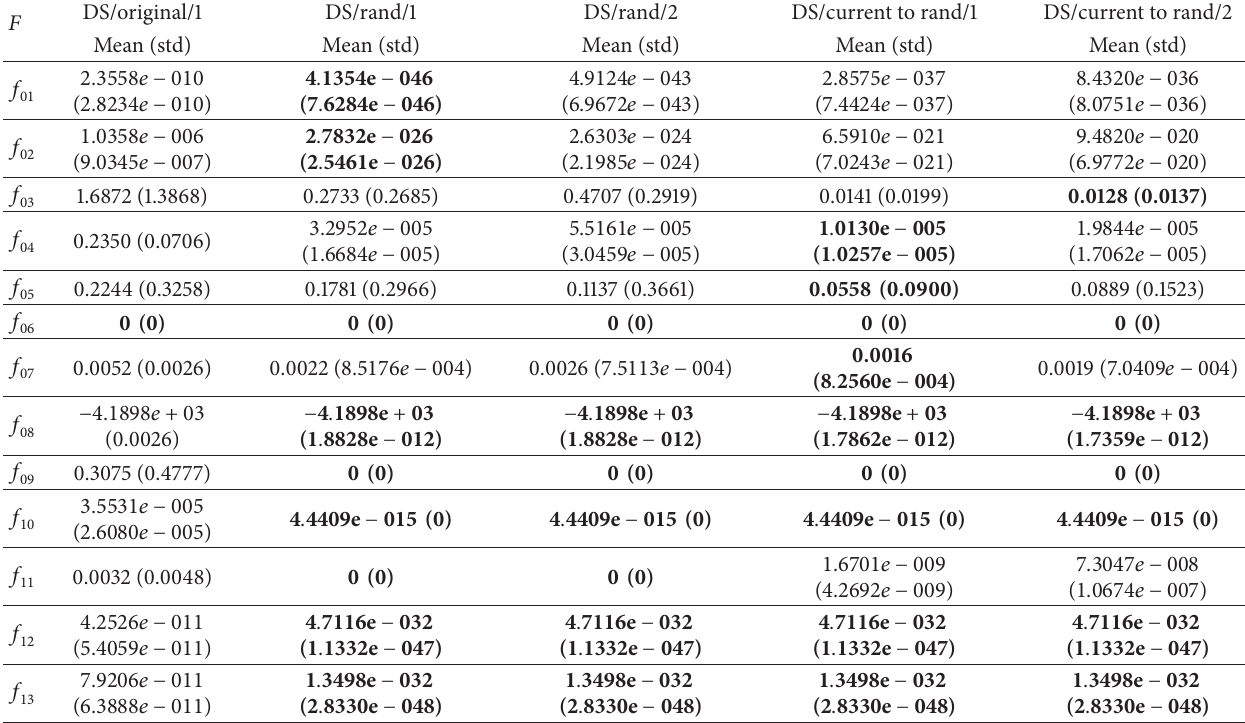
Table 3: Comparisons of different search schemes for 10 D .